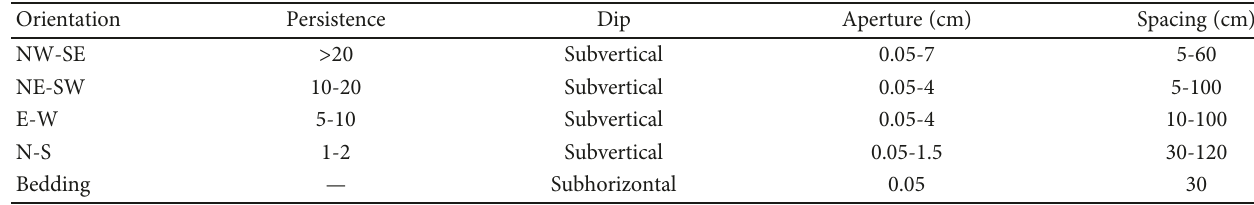
Figure 5: Rose diagrams showing the observed fracture orientations at each geomechanical station. The colour of each diagram corresponds to the colour of the triangles identifying the location of each geomechanical station in Figure 1(b). Table 2: The main joint sets identi fi ed in the Eastern Aurunci